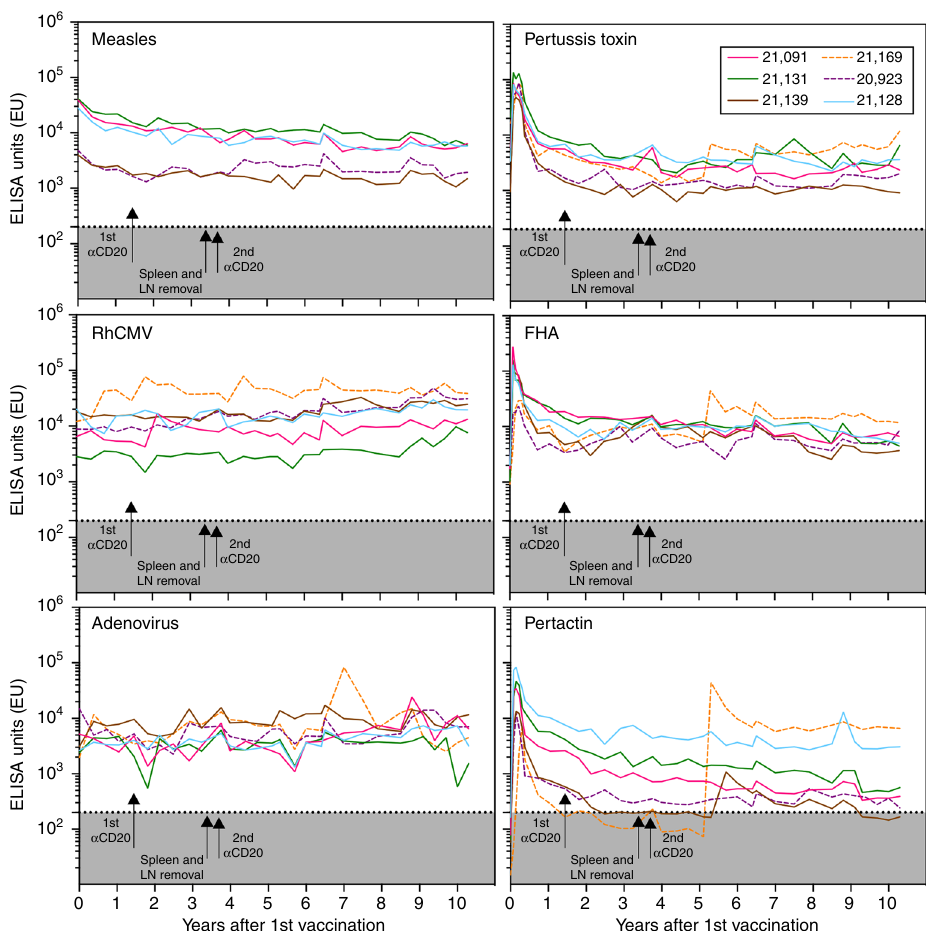
Fig. 2 Longitudinal analysis of antibody responses to multiple antigens after vaccination or infection. Serum antibody titers were measured at the indicated time points for a paramyxovirus that is antigenically related to measles virus (Measles), rhesus cytomegalovirus (RhCMV), adenovirus, pertussis toxin, fi lamentous hemagglutinin (FHA), and pertactin. Arrows indicate the dates when anti-CD20 administration was performed or when splenectomy and draining lymph nodes (LN) were surgically removed. Control animals, Rh#20923 and Rh#21169, did not have anti-CD20 treatment or surgeries performed and are represented by dashed lines. The gray shaded region below the dotted line ( < 200 ELISA units) represents the points in which ELISA titers become equivocal or are below the limit of detection. Control animal Rh#21169 was seronegative for measles virus